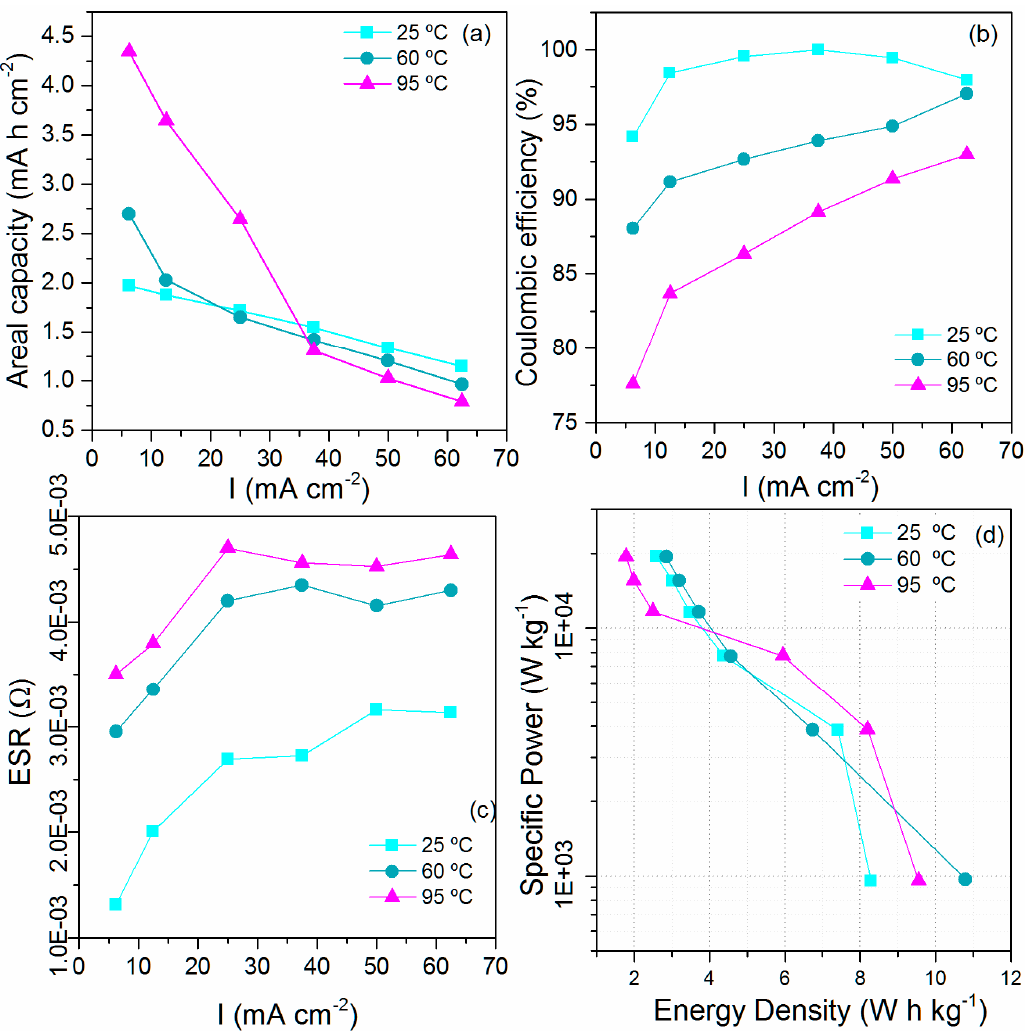
Figure 9. ( a ) Areal capacity distribution; ( b ) coulombic efficiency of ECs; ( c ) ESR of ECs; and ( d ) Ragone plot for the electrochemical performance of symmetrical ECs.